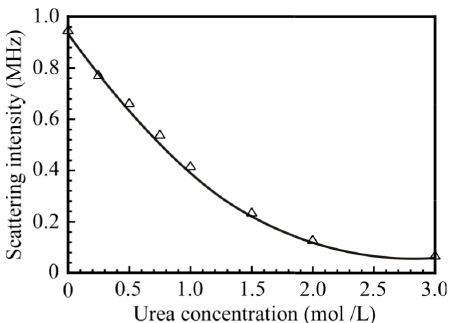
Figure 11. The scattering intensity of the PNaSS 58 – b –PAA 125 /PNaSS 58 – b –PNIPAM 115 complex at C p = 4.4 g/L in 0.1 M NaCl as a function of the urea concentration.